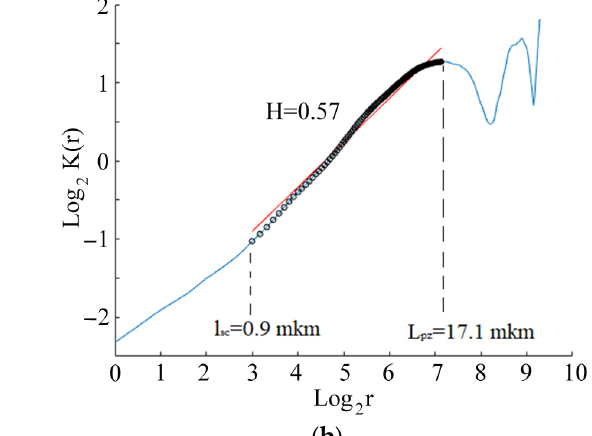
( d ) Figure 15. Images of the damage surface in the crack propagation area (zone 2) of the CG Ti-45Nb alloy: ( a ) optical image of scanning area; ( b ) surface profile; ( c ) 2D-relief map; ( d ) 3D-relief map. The value of the linear section of the correlation function corresponds to the value of the fractal dimension of the crack profile, propagating according to Paris’s law. Both the